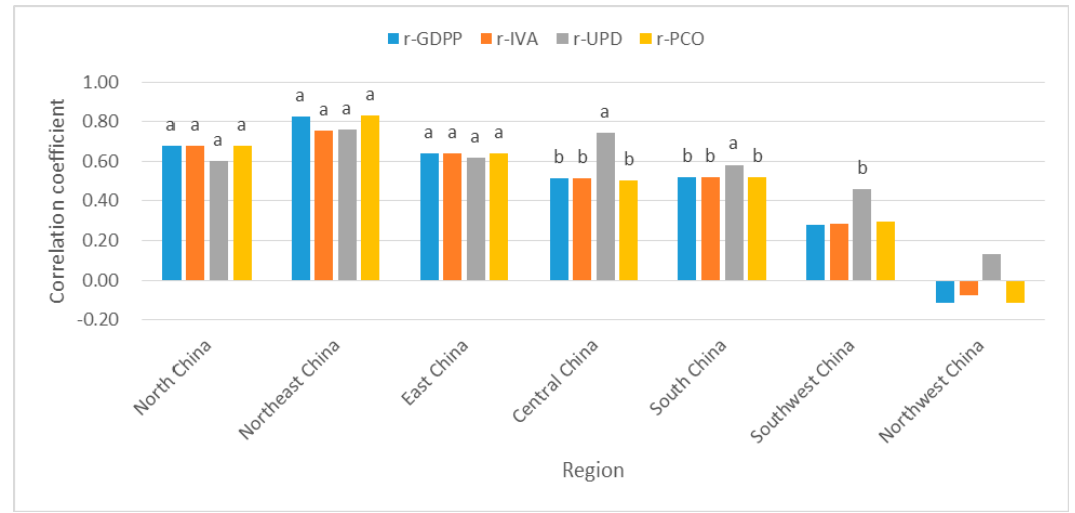
Figure 8. The correlation coefficient (r) values between PM 2.5 and GDPP (IVA, UPD or PCO) in the geographical subareas. Notes: a, b represent coefficients significant at the 1%, 5% levels, respectively. No letters above the bar chart indicate insignificance.